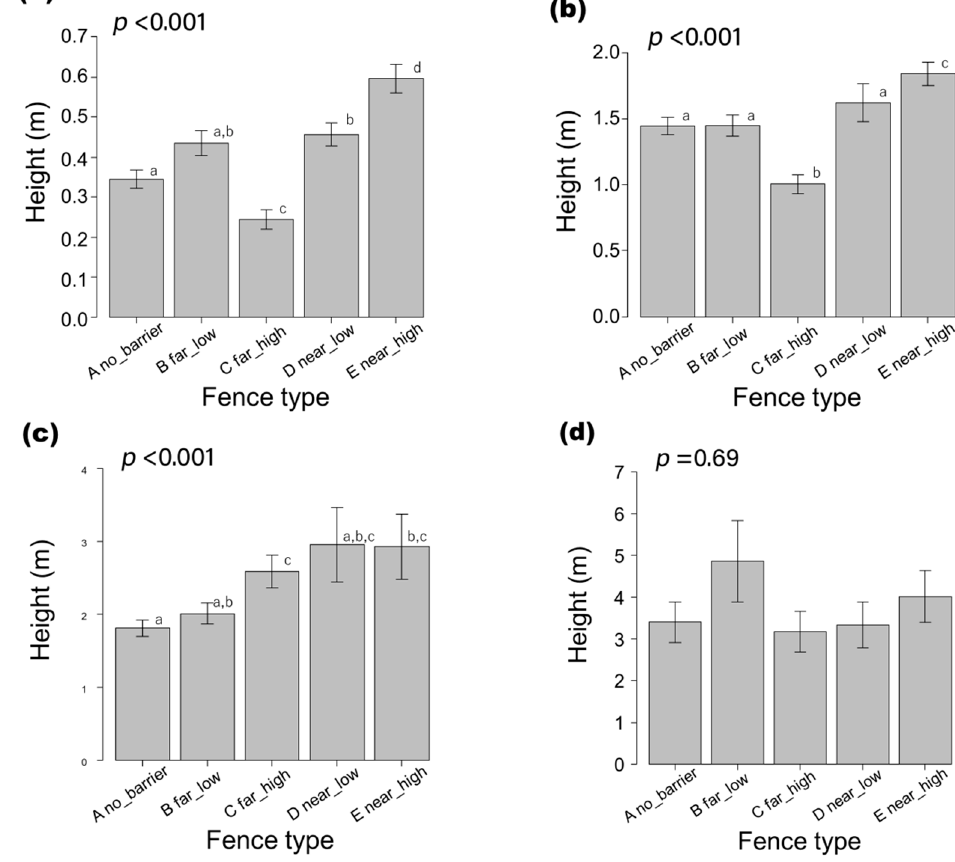
Figure 4. Effect of fence type on flight altitude. Average flying height for ( a ) distance class 0 (0–1 m), ( b ) distance class 1 (1–5 m), ( c ) distance class 5 (5–10 m), and ( d ) distance class 10 (>10 m). ( a – c ) showed significant differences among fence types, while ( d ) showed no significant differences. Letters above the error bars represent the results of Bonferroni’s post-hoc pairwise comparison test. Bar heights are the means ± standard error.